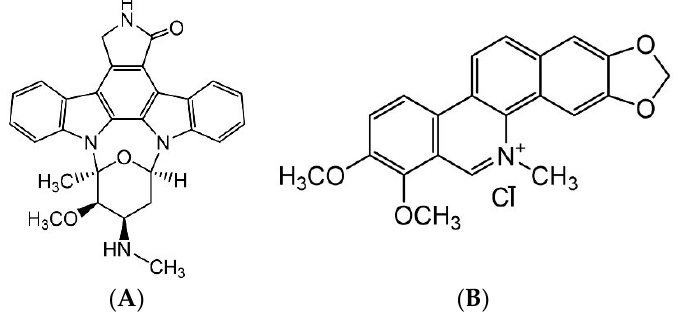
Figure 1. Chemical structures of ( A ) staurosporine and ( B ) chelerythrine